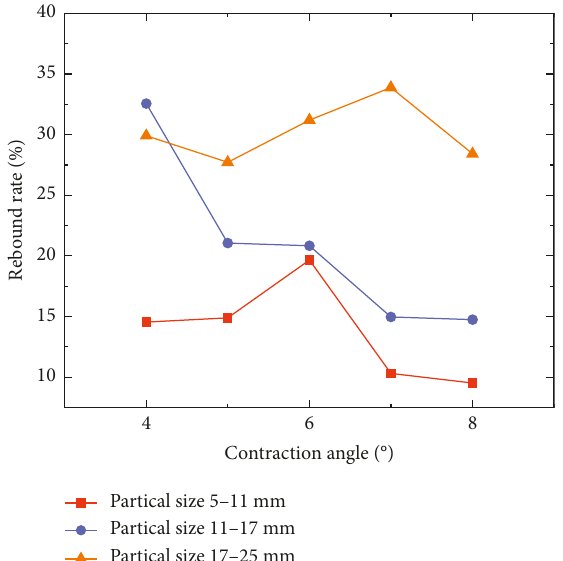
Figure 12: Relationship between shrinkage angle and rebound